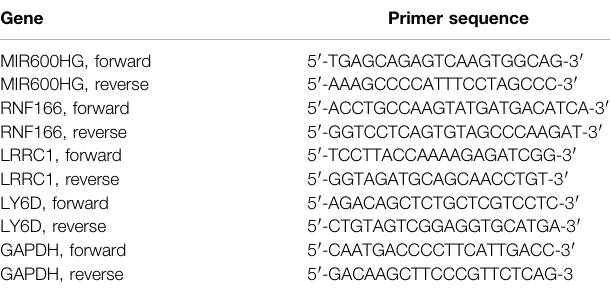
TABLE 1 | Sequences of gene-speci fi c primers used for real-time RT-qPCR.